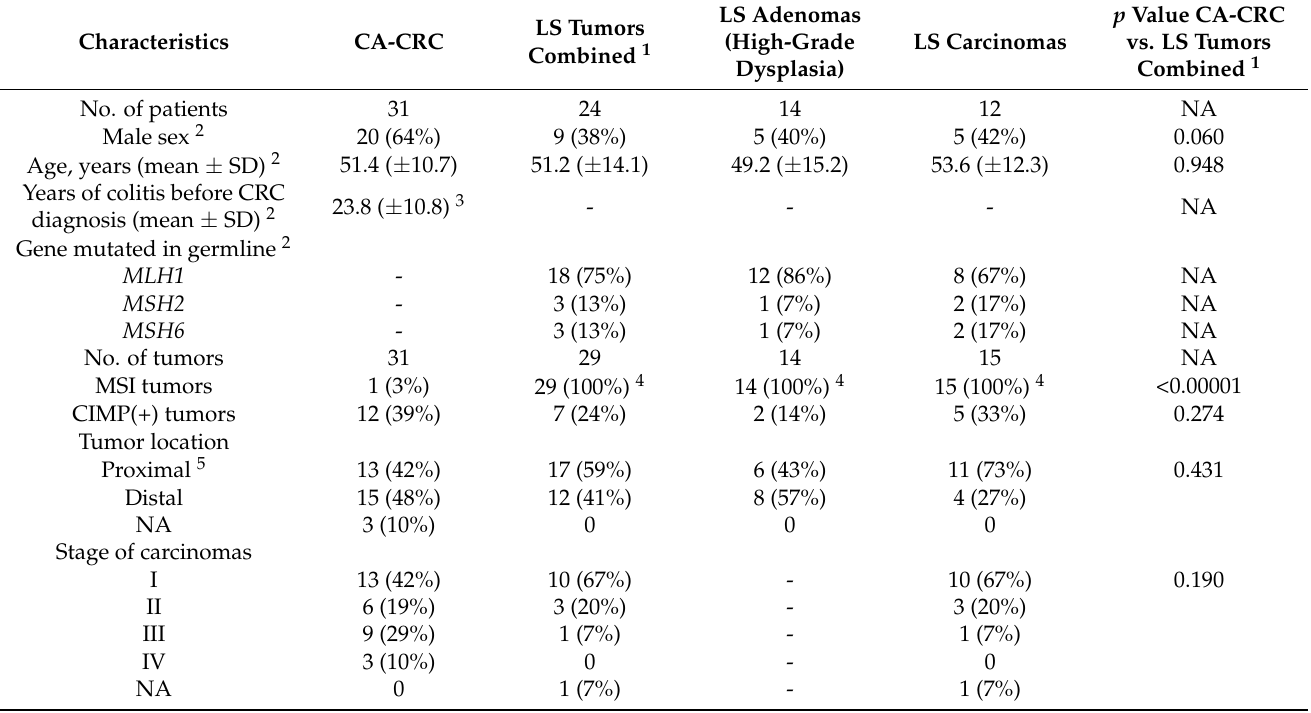
Table 1. Characteristics of the patient